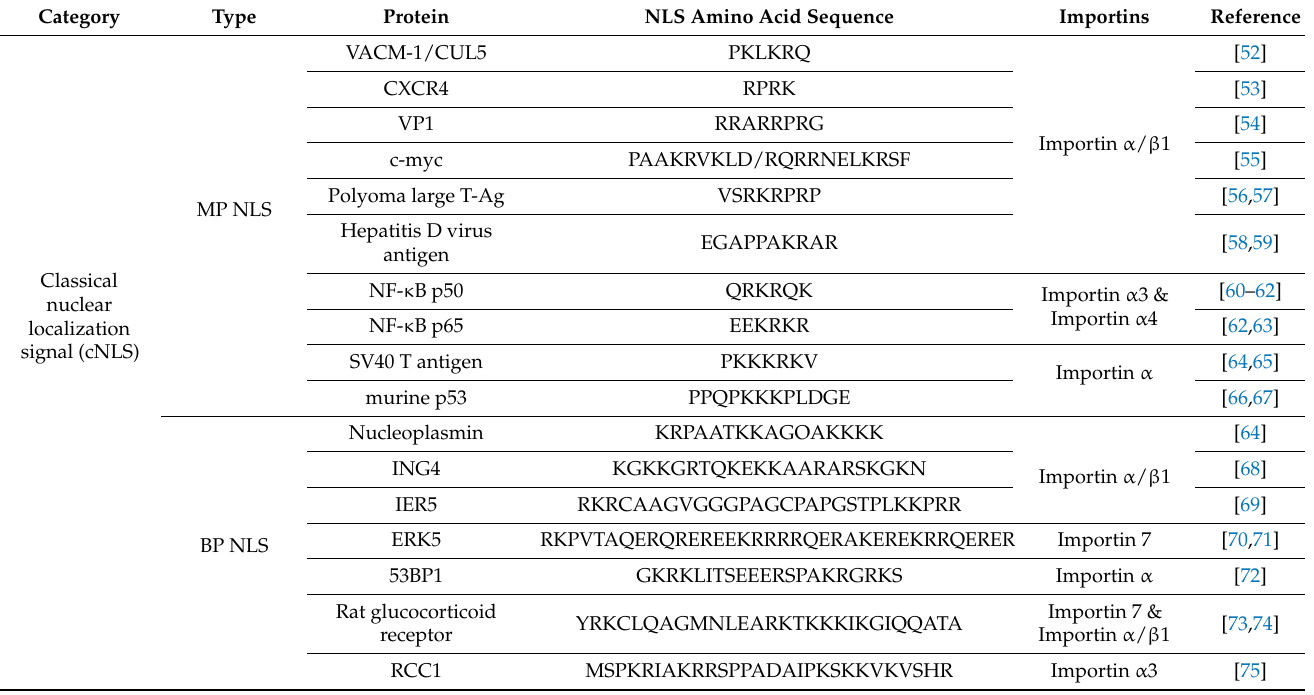
Table 1. Different NLS sequences recognized by different